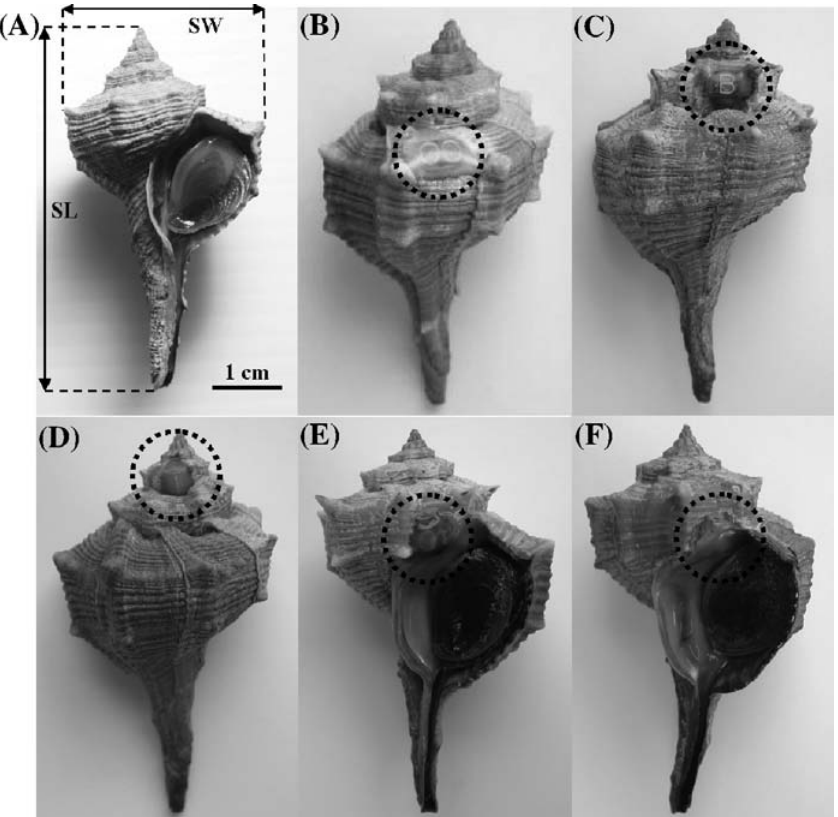
Fig . 2. − Illustration of shell measurements and details of the marking technique of Bolinus brandaris : (A) measurement of shell length (SL) and shell width (SW); (B) position of the tag at marking (dotted circle on the penultimate growth band on the last whorl of the shell); (C, D) position of the tag at recapture (dotted circles on different growth bands on the penultimate and antepenultimate whorls of the shell); (E, F) marked-recaptured specimens with the tag partially or totally covered by the shell deposition during growth (dotted circles on the shell